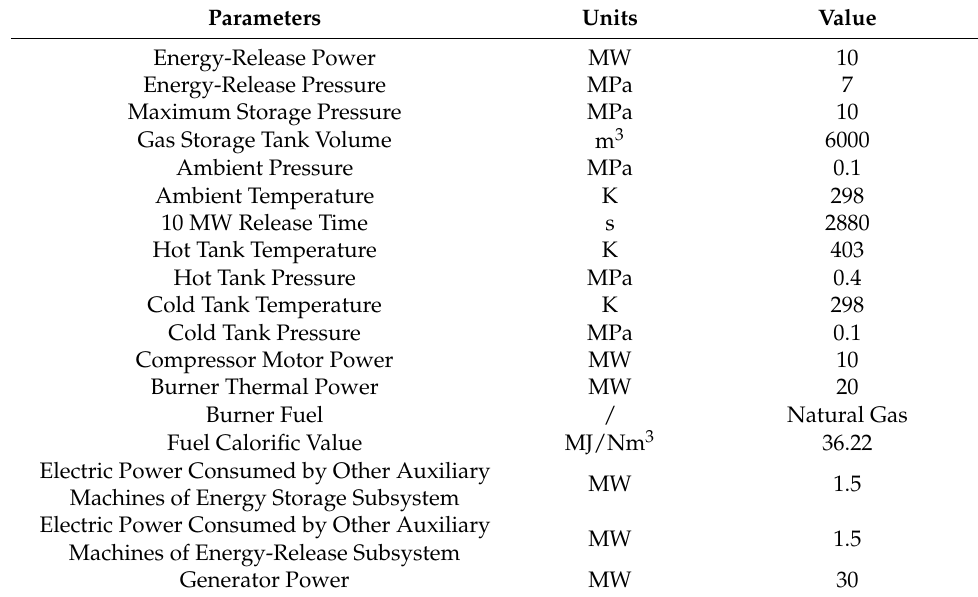
Table 2. Basic design parameters for the new CAES system.